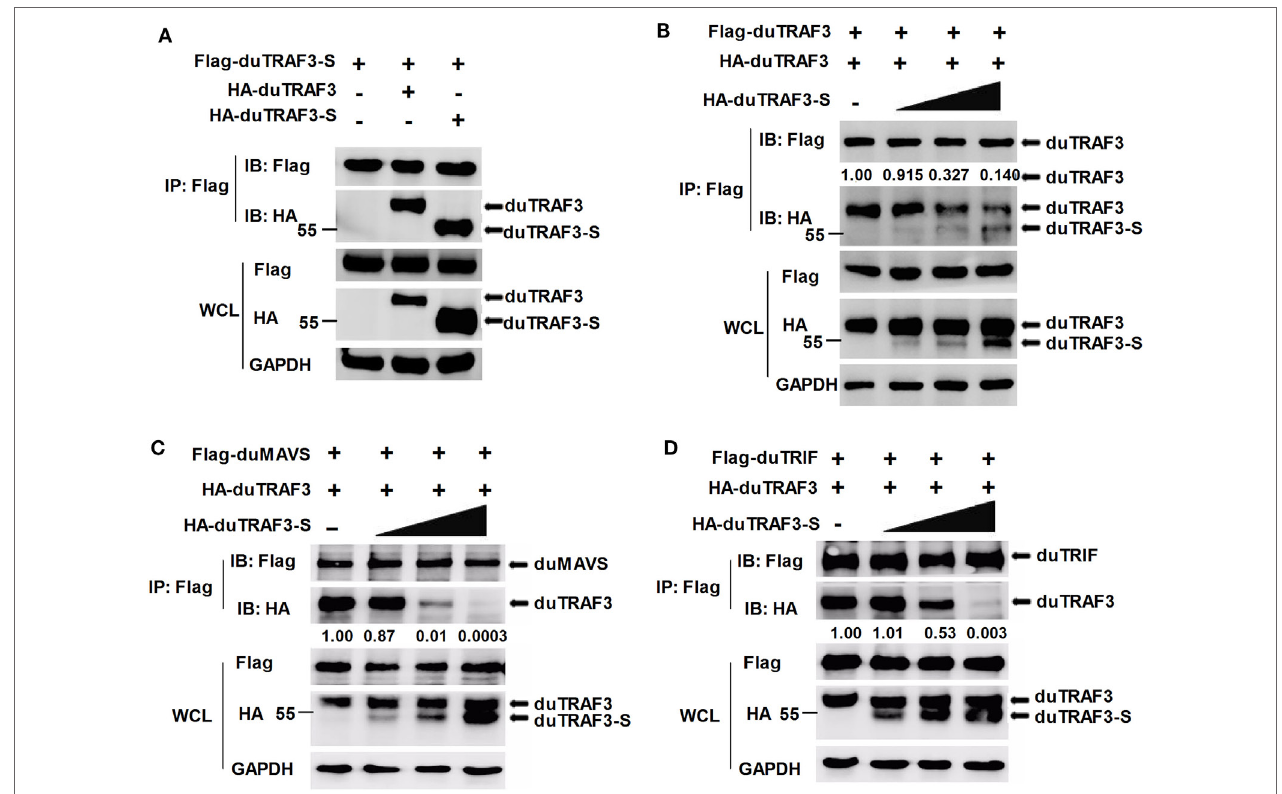
FigUre 7 | Spliced isoform of duck TRAF3 (duTRAF3-S) forms a hetero-oligomerization with duck TRAF3 (duTRAF3) and disrupts the interaction between duTRAF3 and duMAVS or duTRIF. (a) 293T cells were transfected with Flag-tagged duTRAF3-S and HA-tagged duTRAF3 or duTRAF3-S. (B–D) 293T cells were transiently transfected with Flag-duTRAF3 (B) or Flag-duMAVS (c) or Flag-duTRIF (D) and HA-TRAF3 together with an increasing amount of HA-duTRAF3-S (0.5, 1, 2 µg). Twenty-four hours after transfection, the cell lysates were collected and subjected to immunoprecipitation and immunoblotting using the indicated antibodies. Co-Immunoprecipitation (Co-IP) was performed with anti-Flag, and the precipitates were probed with anti-Flag and anti-HA. The protein values were calculated by using Image-Pro Plus